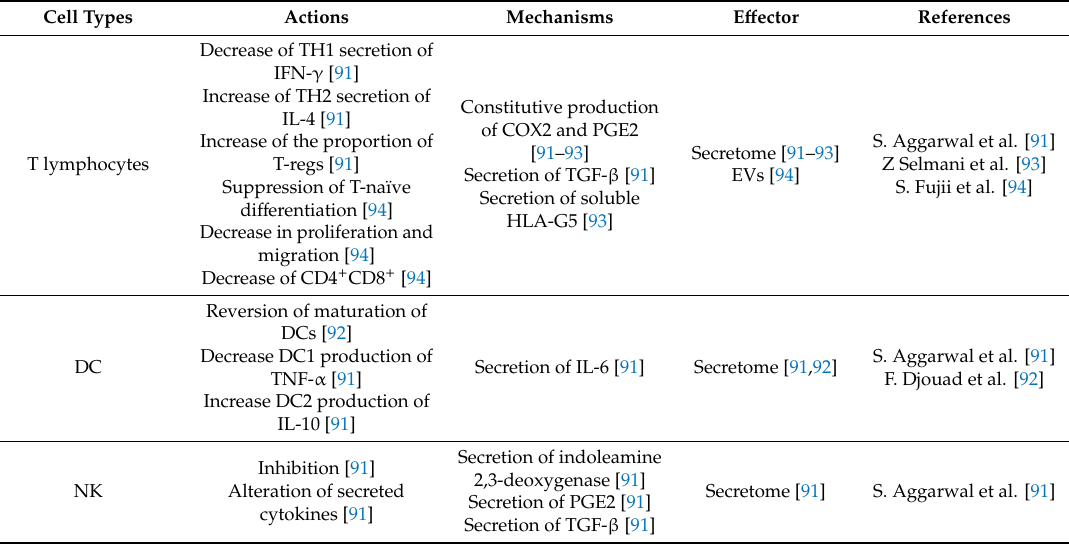
Table 2. Immunomodulatory properties of MSC secretome /